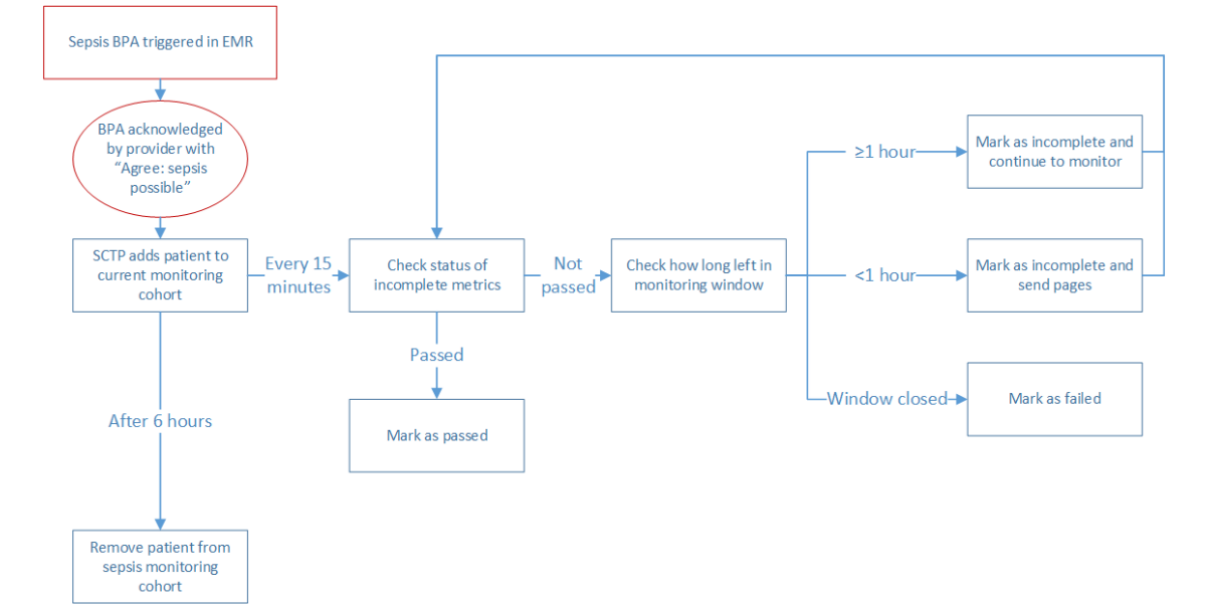
Figure 1. Sepsis care tracking platform page generation logic. BPA: best practice alert; EMR: electronic medical record; SCTP: Sepsis Care Tracking Platform; SEP-1: sepsis core